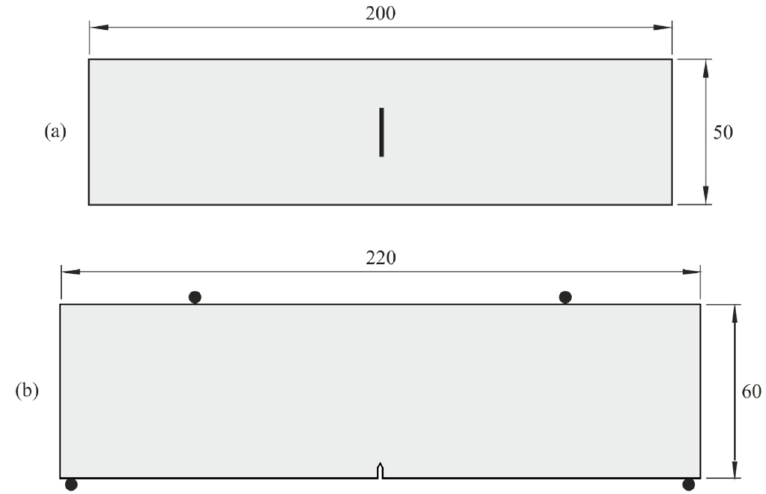
Figure 5. Specimen geometries used in the crack front shape evaluation: ( a ) 6082-T6 aluminium alloy and ( b ) polymethyl methacrylate (PMMA). All dimensions are in mm.